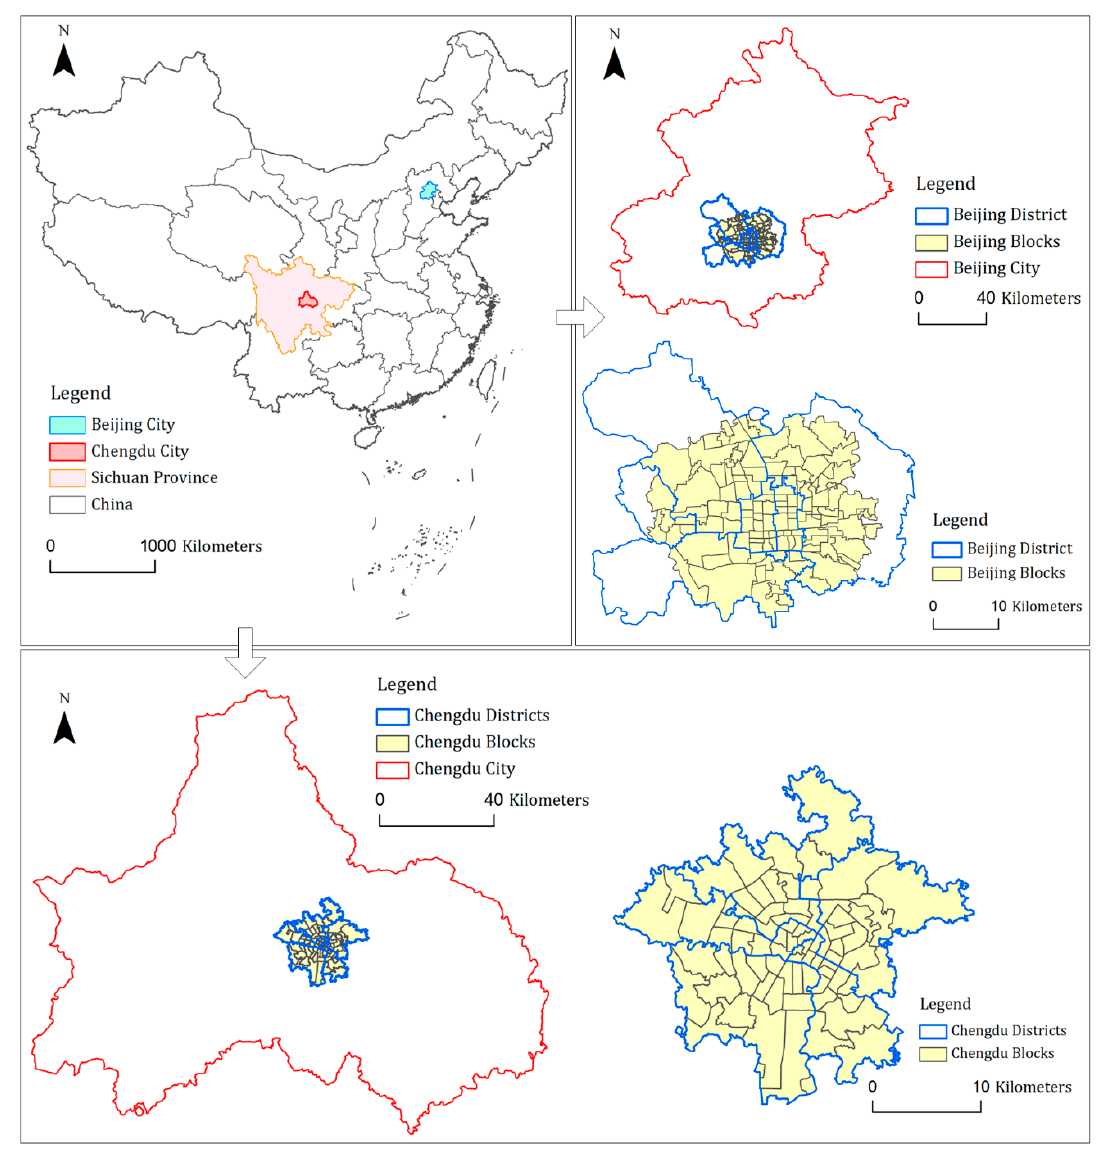
Figure 1. Study areas of this research.